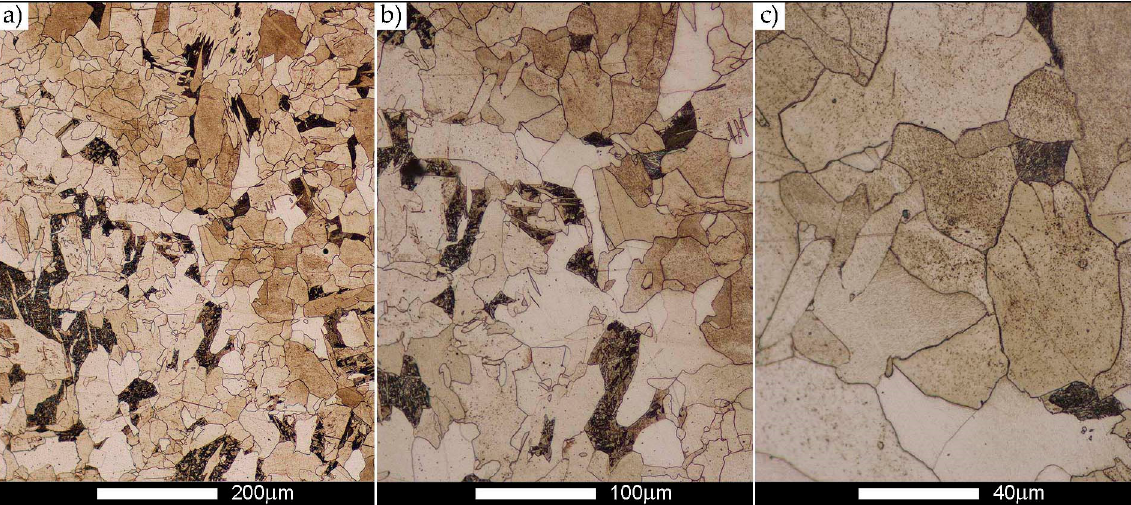
Figure 55. Welded joint microstructure of Hardox 450 steel with visible prior austenite grain boundaries, austenitised at 1200 ◦ C—FL zone shown in Figure 2. ( a ) 100 × ; ( b ) 200 × ; ( c ) 500 × .